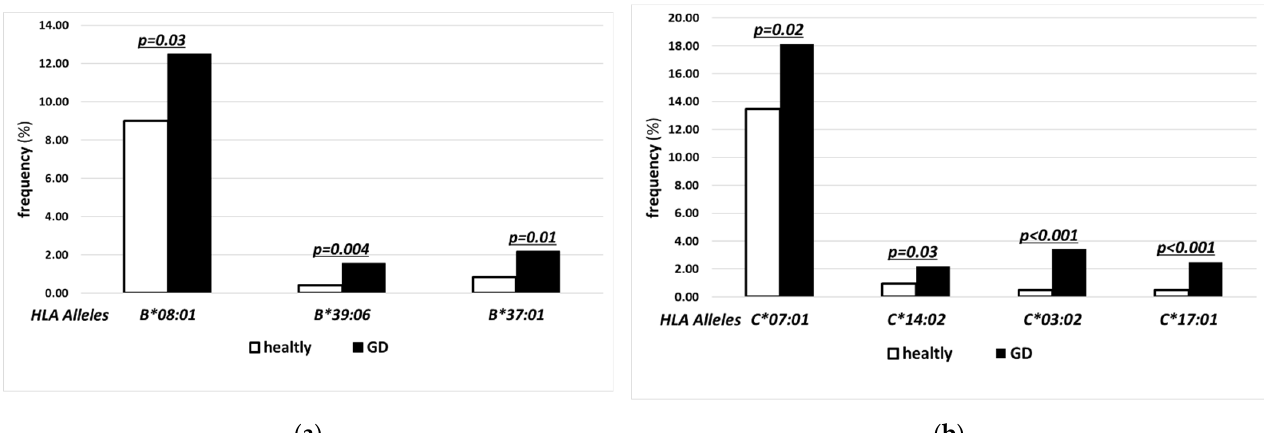
Figure 1. Frequencies (%) of human leukocyte antigen (HLA) over-represented alleles with statisti- cally significant difference between control (open bars) and Graves’ disease (GD) patients (solid bars) for major histocompatibility complex (MHC) class I alleles: HLA-B ( a ) and HLA-C ( b